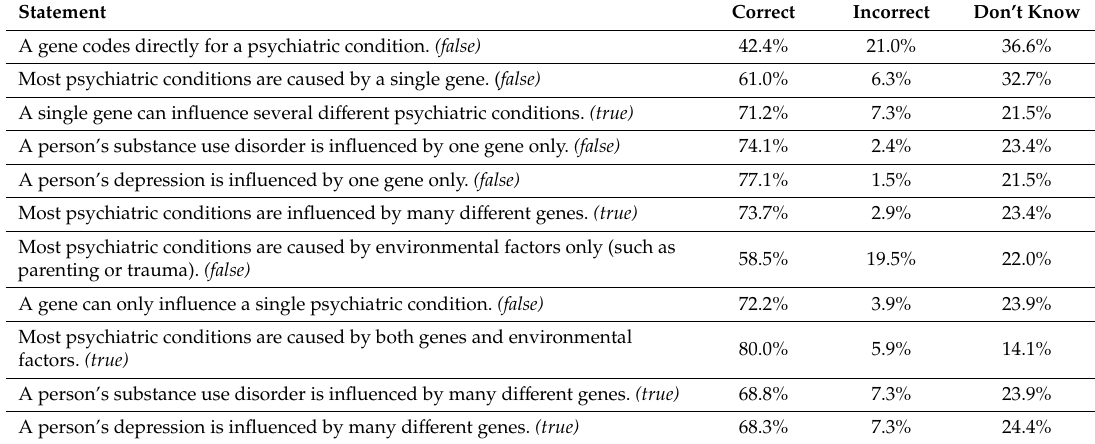
Table 6. Response patterns for the 11 genetic knowledge items.